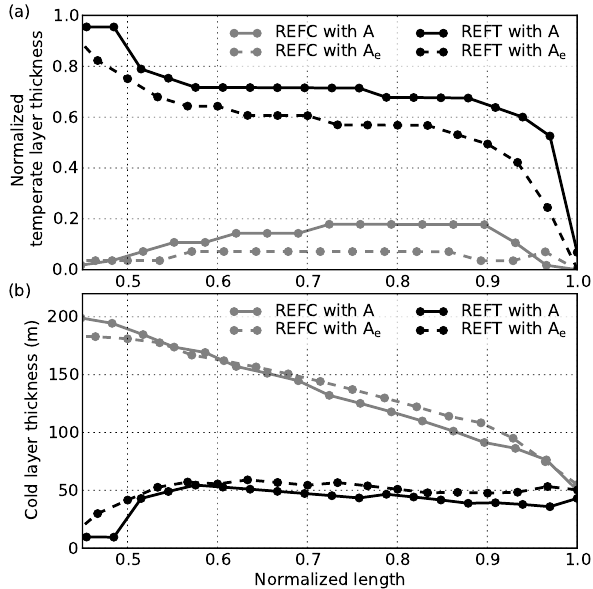
Fig. 3. Effect of flow-law coefficient parameterisation on glacier thermal structure. Glacier geometry evolves in these simulations. The basal temperate layer thickness (a) is normalized to ice thickness. The cold layer thickness in (b) is equivalent to the cold-temperate transition depth. Note that the x -axes begin near the middle of the glacier in order to focus on the cold ablation zone layer.